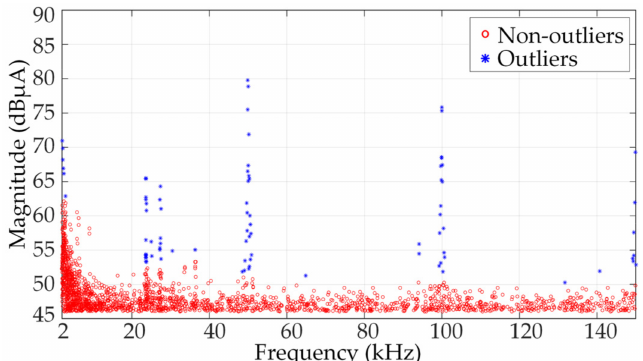
Figure 11. DBSCAN clustering results, points in red were identified as non-outliers, while points in blue were identified as outliers.